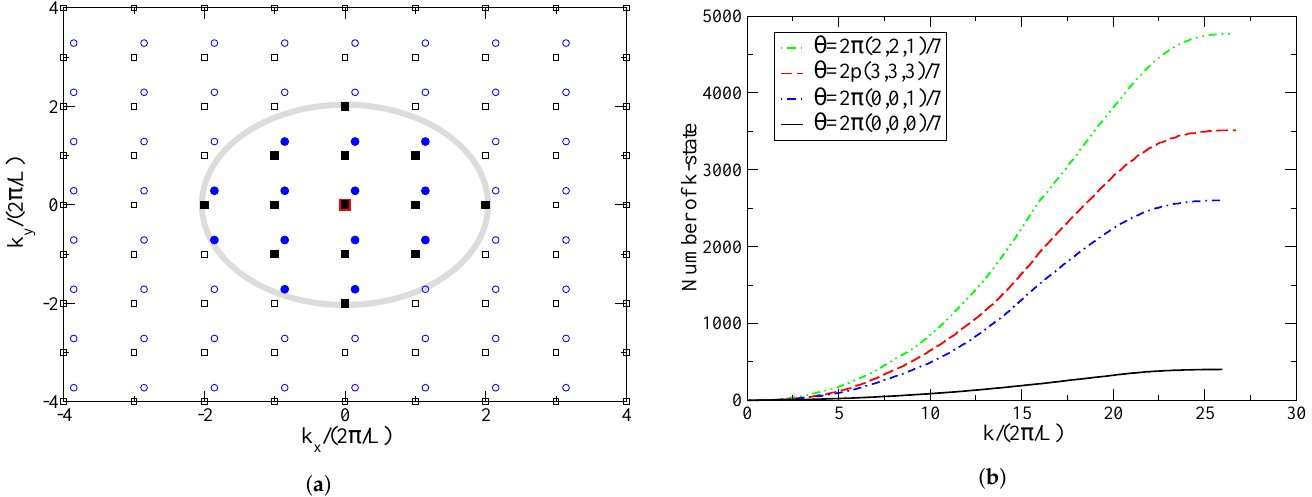
Figure 5. The twisted k -space. Panel ( a ) shows the k -grid of a 2D system with N = 26 free neutrons under PBCs (squares) and twisted boundary conditions (TBCs) (circles) with θ = 2 π ( 1,2 ) /7. The closed symbols represent the filled momentum states, and the closed curve shows the boundary of the filled k -states of the infinite system. Panel ( b ) shows the number of distinct k -magnitudes generated by different twisted